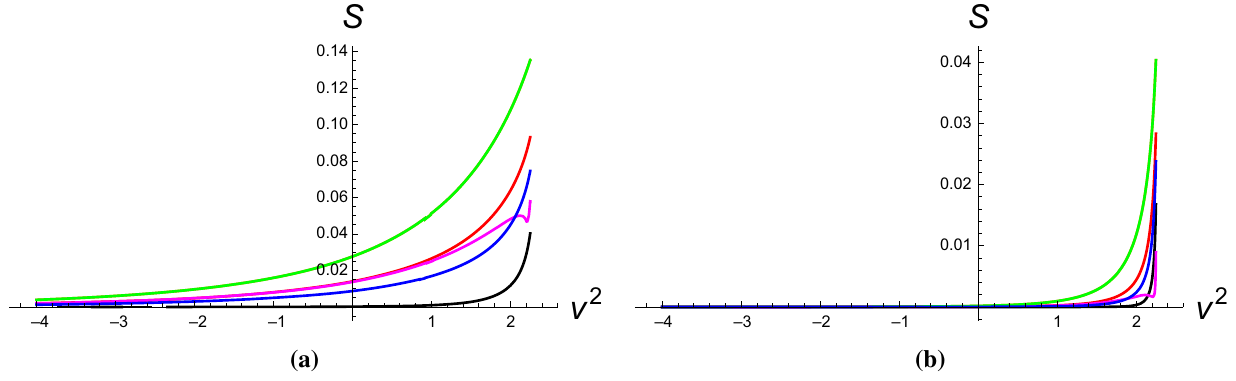
Fig. 4 The Rényi entropy for (a) q = 0 . 5 and (b) q = 2, for various values of θ RL . The green curve corresponds to θ RL = 0 , π/ 2, the red to θ = π/ 6, the blue to θ = π/ 5, the black to θ = π/ 4 and the pink to θ RL RL RL